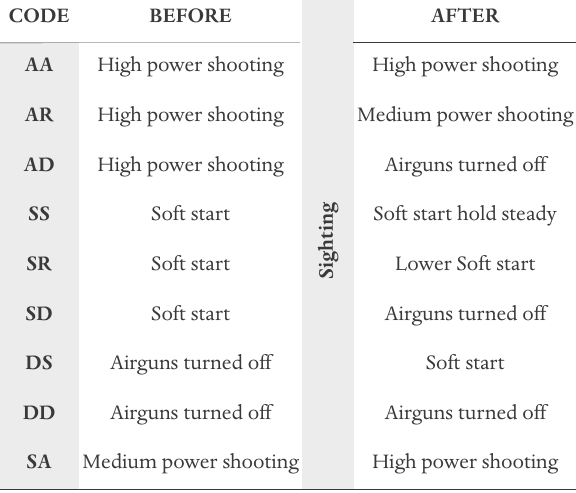
Table 1. Classification of power changing events of noise source.